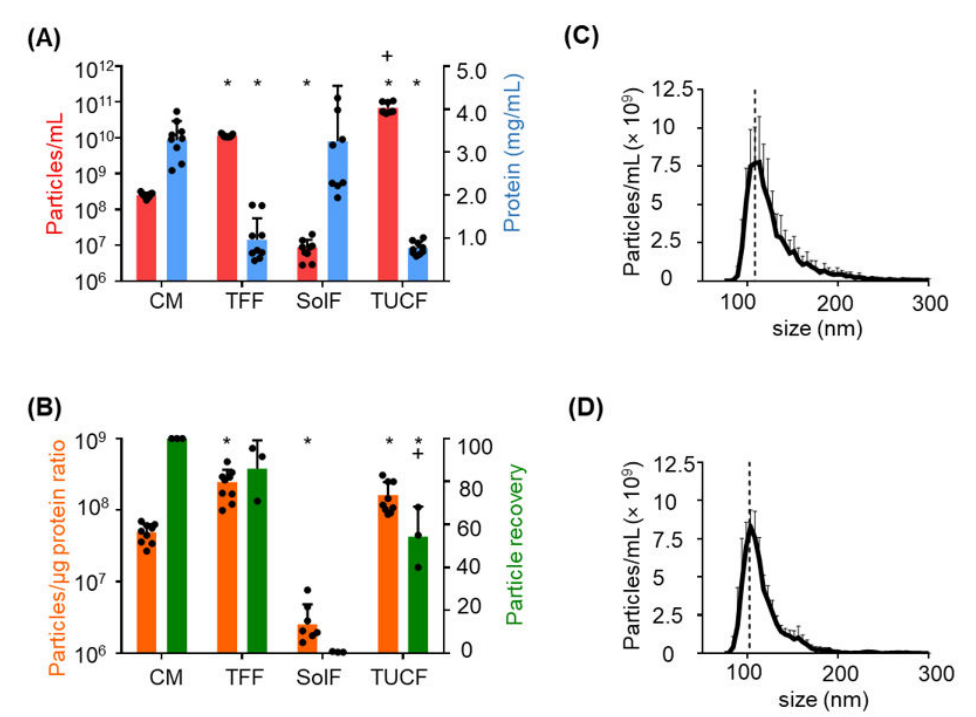
Figure 2. Monitoring iPSC-EV purification efficacy. ( A ) Particle concentration (red bars) as mea- sured by tunable resistive pulse sensing (TRPS) and protein concentration (Bradford; blue bars) of conditioned media (CM), EVs after tangential flow filtration (TFF), cell-secreted soluble factors (SolF) separated in the TFF permeate, EVs ultra-centrifuged after TFF (TUCF). Mean ± SD of three independent experiments (* p < 0.05; compared with CM and (+ p < 0.05; compared with TFF). ( B ) The particle/ µ g protein ratio (orange bars) was calculated by dividing the total particle count by total protein amount. Mean ± SD of three independent experiments. Efficiency of EV production (particle recovery; green bars) comparing the number of particles in the starting material (CM = 100%) to the particle number after TFF, in the SolF and after TUCF. ( C , D ) Illustration of particle size after ( C ) TFF and ( D ) TUCF purification. Lines represent mean data from three independent experiments ± SD. Dotted line indicates particles size peak mode of 109 nm in ( C ) and 103 nm in ( D